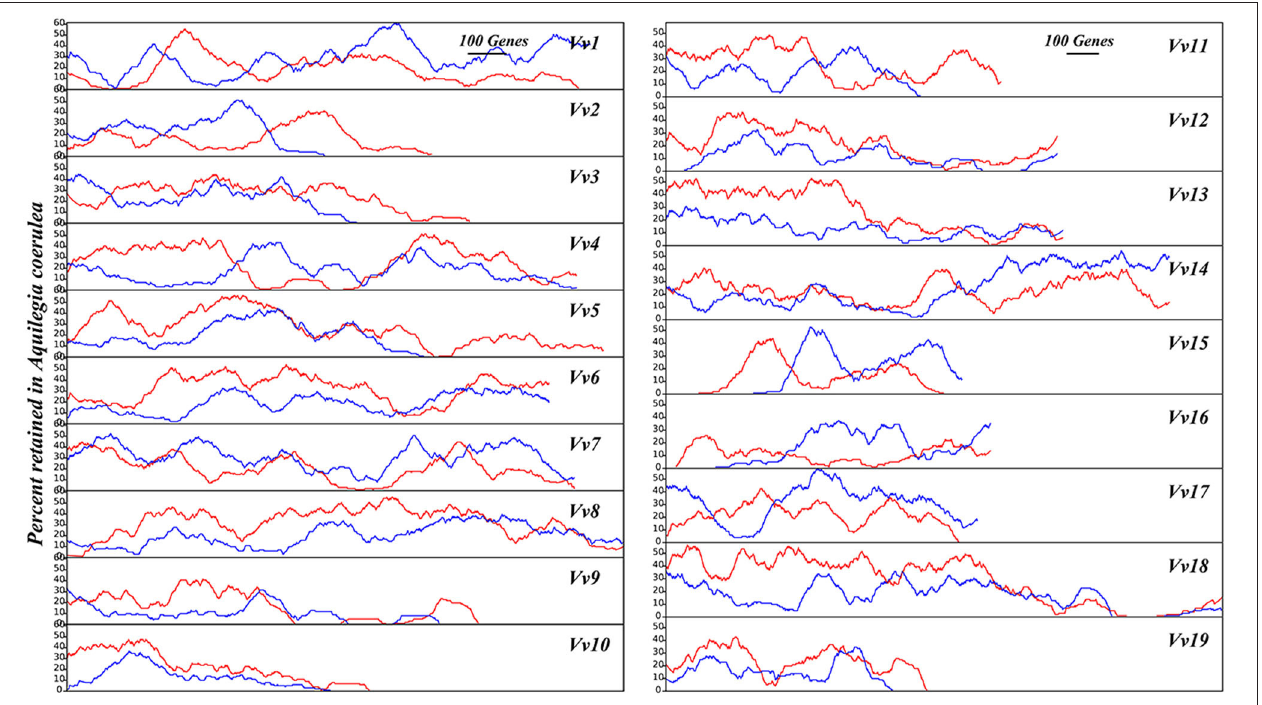
FIGURE 6 | A. coerulea gene retention along corresponding orthologous V. vinifera chromosomes. Using the V. vinifera chromosomes as the reference, with 100 genes as a sliding window, the percentage of gene retention in two sets of A. coerulea subgenomes is shown in red and blue lines,